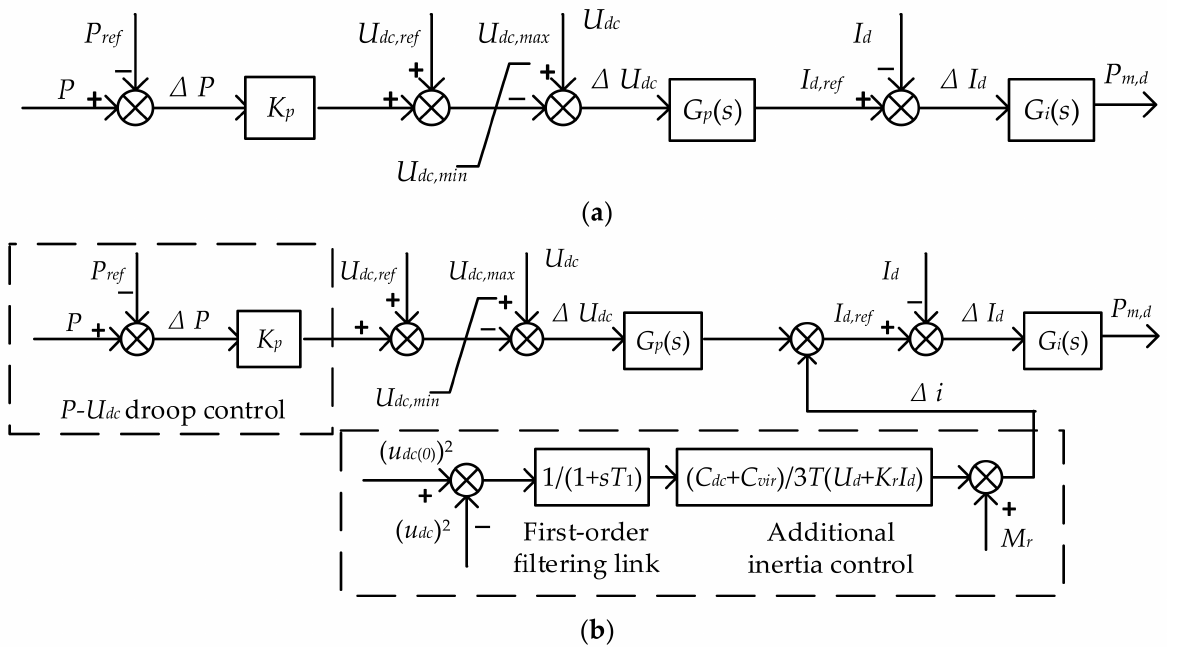
Figure 6. ( a ) Conventional control block diagram for converters. ( b ) Additional inertia control block diagram of voltage outer loop of